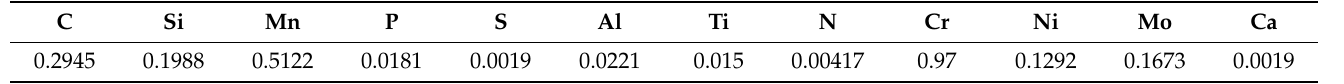
Table 1. Composition of experimental steel (mass fraction,